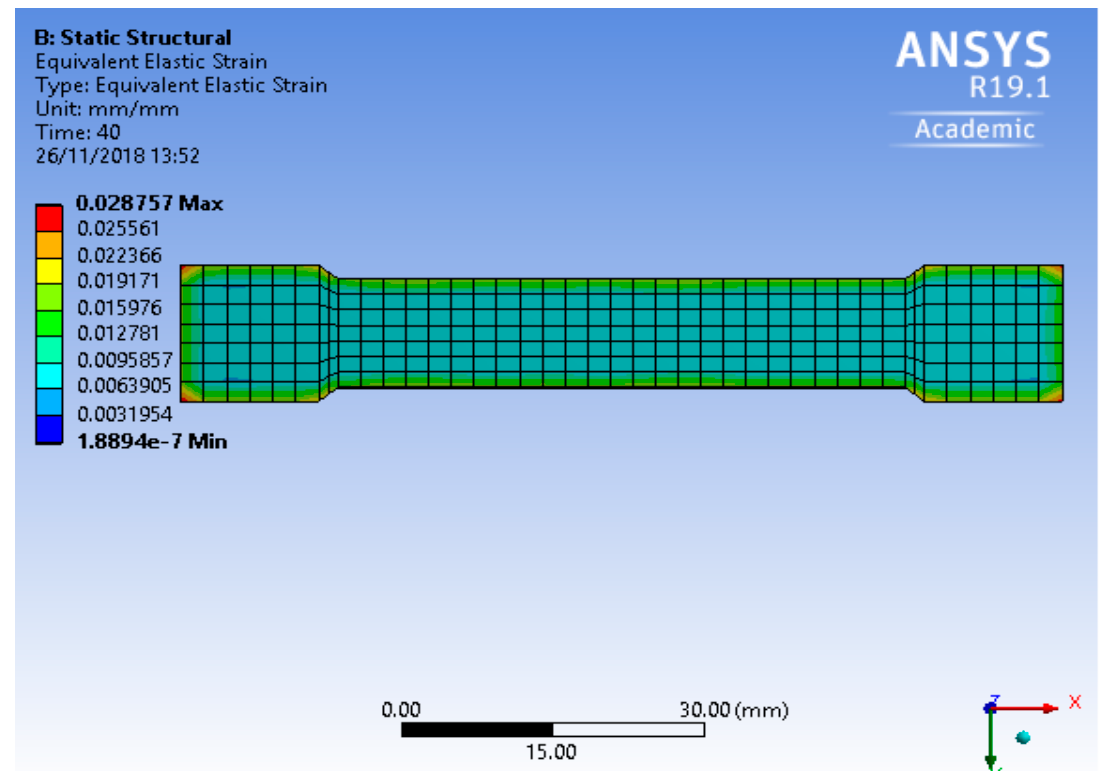
Figure 11. Thermal strain on the foil adjacent to the hot plate.